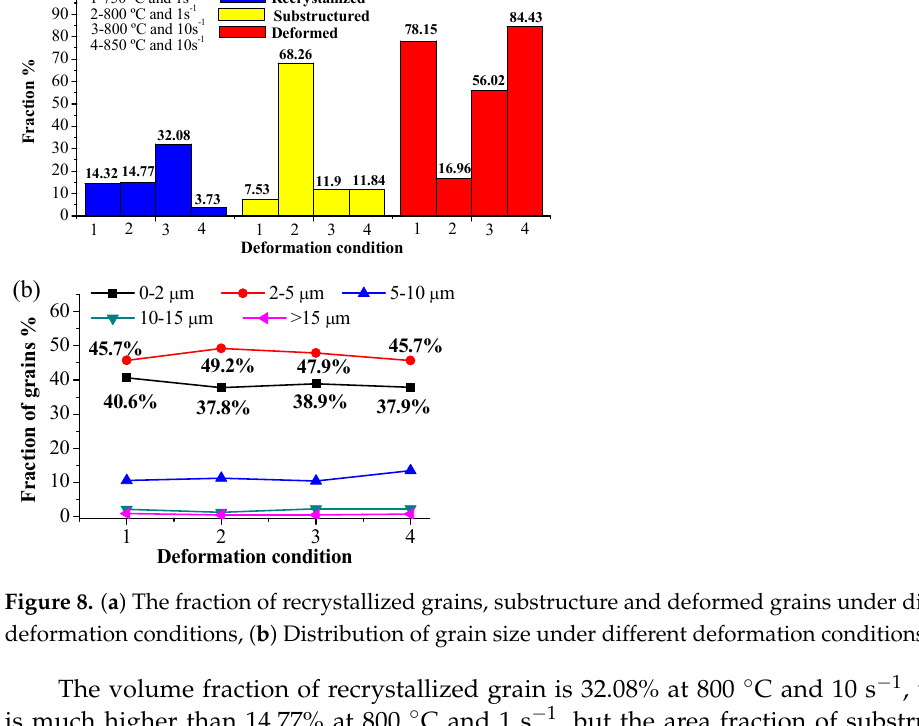
Figure 7. EBSD maps of recrystallized, substructure, and deformed grains,and misorientation angle distributions( a , c ) 750 °C, 1 s − 1 ;( b , d ) 800 °C, 1 s − 1 ; ( e , g ) 800 °C, 10 s − 1 ; ( f , h ) 850 °C, 10 s − 1 .